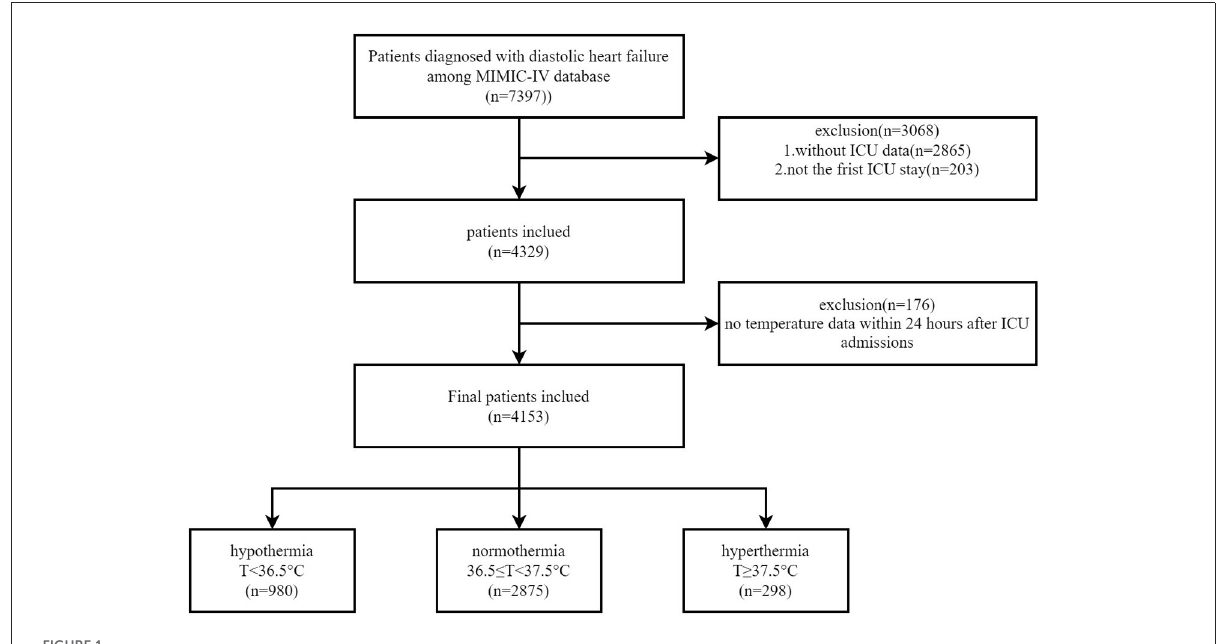
FIGURE1 A flowchart of patient